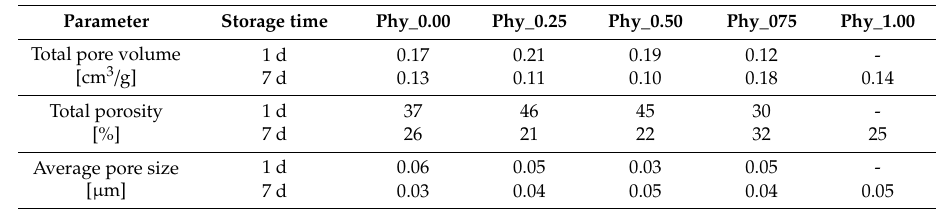
Table 7. The total pore volume, porosity and average pore size of all samples stored for 1 d and 7 d at 37 °C and 100% humidity, measured by Hg-porosimetry.